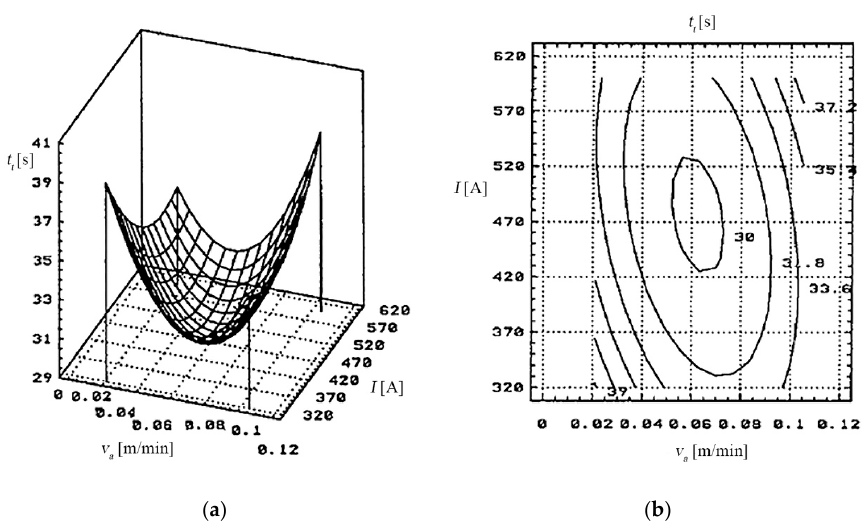
Figure 16. The dependency of the cutting time ( t t ) to the feeding rate ( v a ) and the working current: ( a ) 3D graph, ( b ) 2D graph.